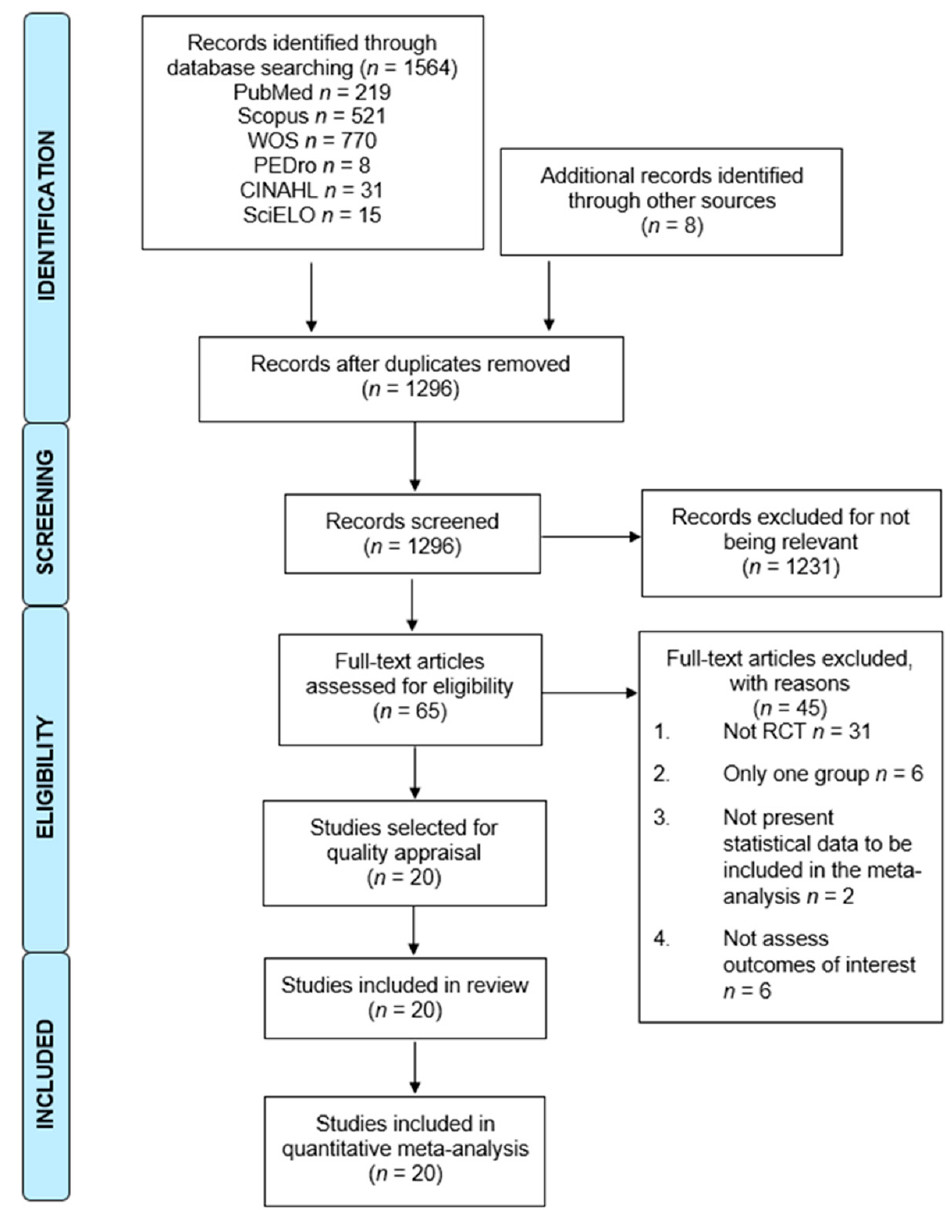
Figure 1. PRISMA flow chart of the study selection process.